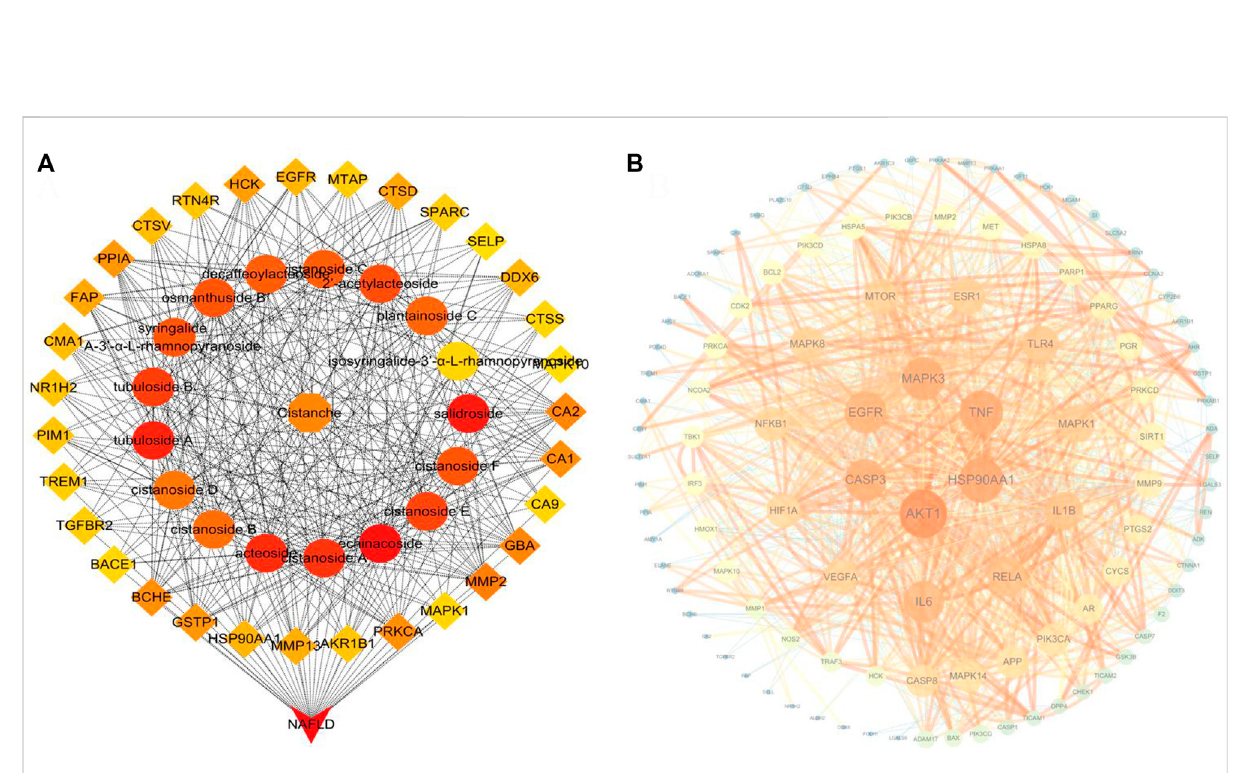
FIGURE 7 (A) Top 50 nodes of the compound – drug – target – disease network; (B) PPI network of CD candidate